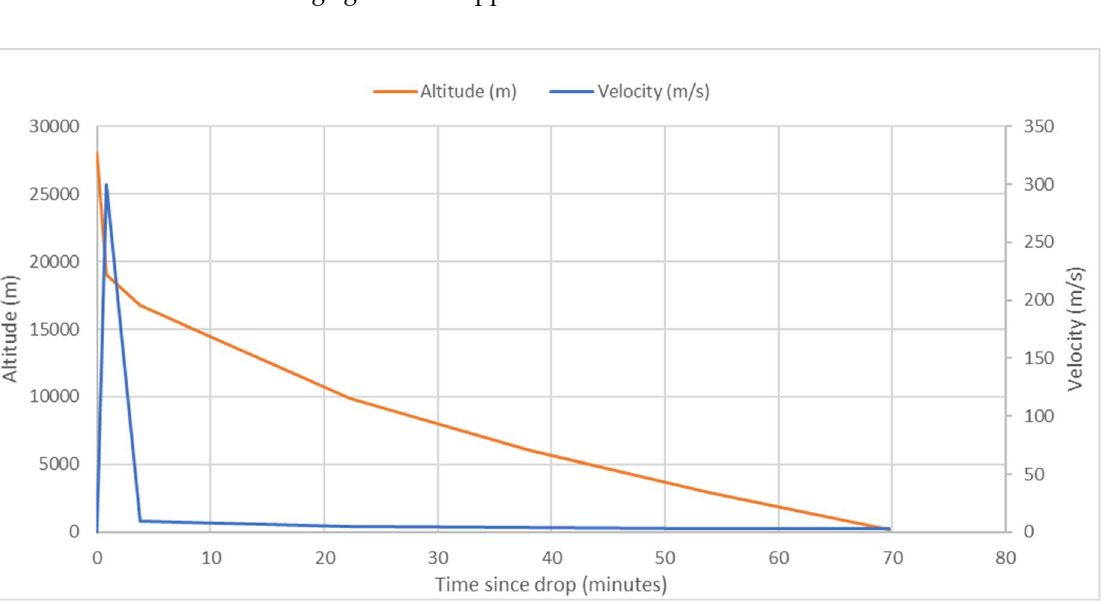
Figure 32. Descent profile.